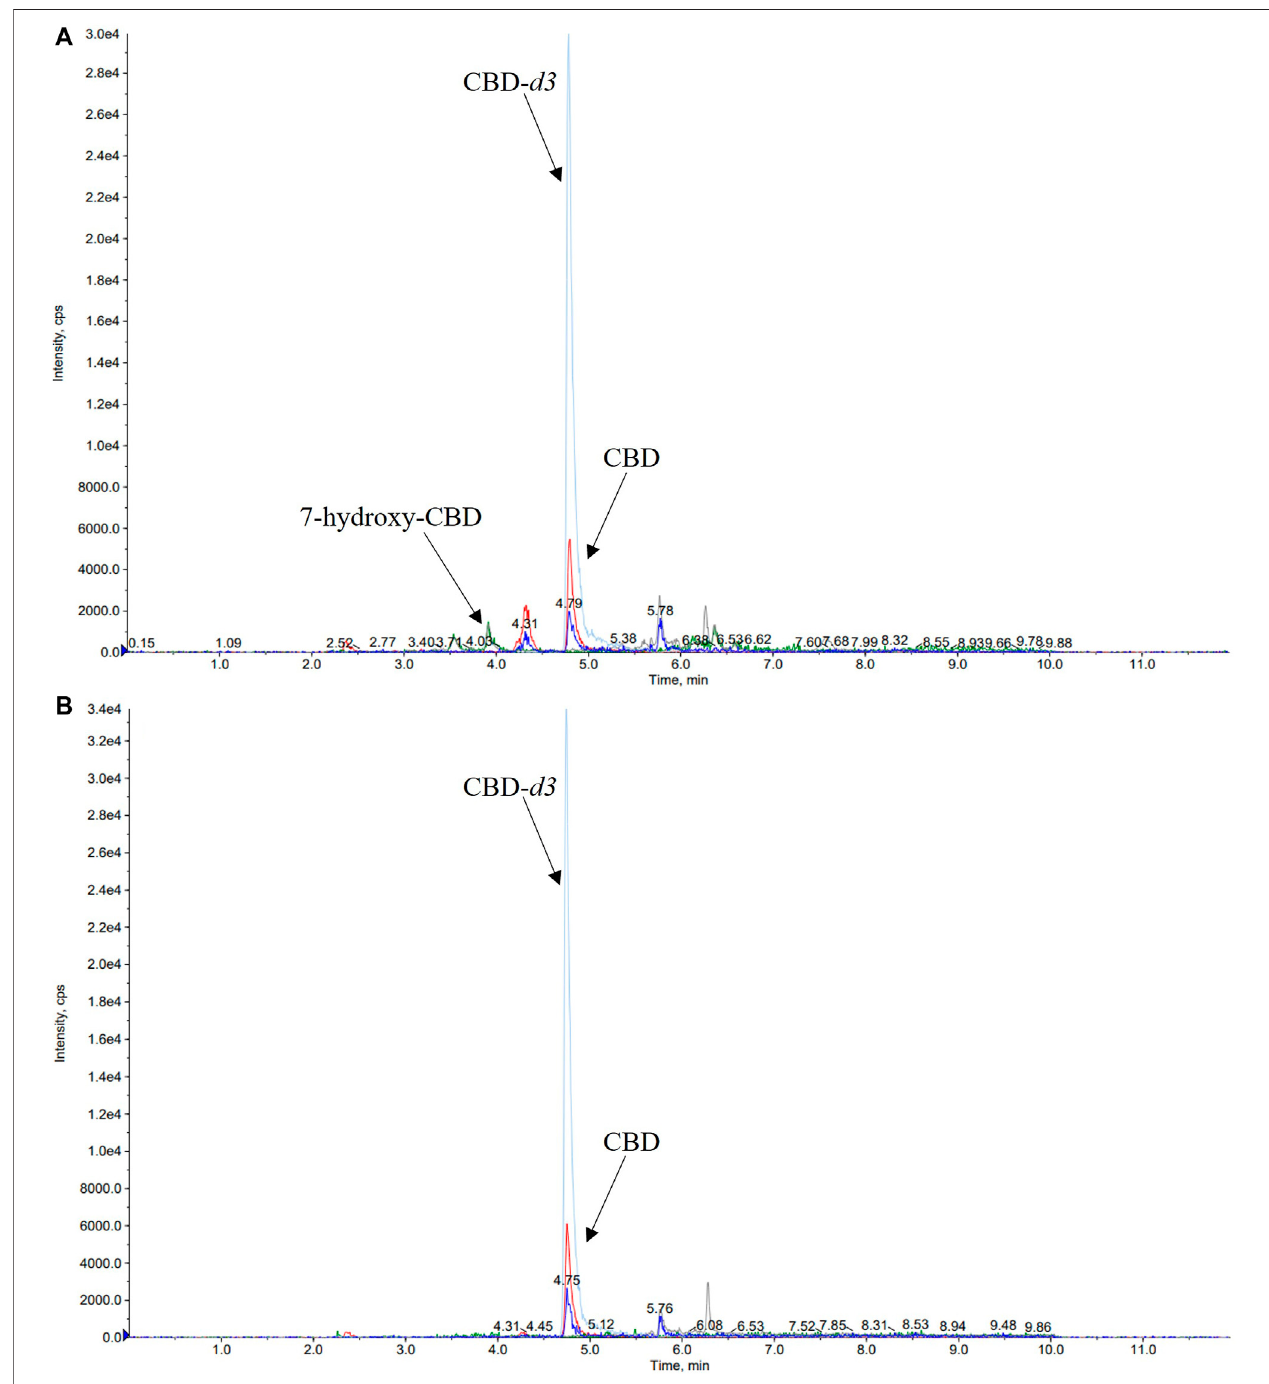
FIGURE 4 | Representative chromatograms of serum (A) and saliva (B) samples of a patient taking cannabidiol (CBD) at a dosage of 6.6 mg/kg/day. The serum concentration of 7-hydroxy-CBD and CBD was 11.2 ng/ml and 22.5 ng/ml, respectively. CBD salivary concentration was 23.2 ng/ml while 7-hydroxy-CBD was not